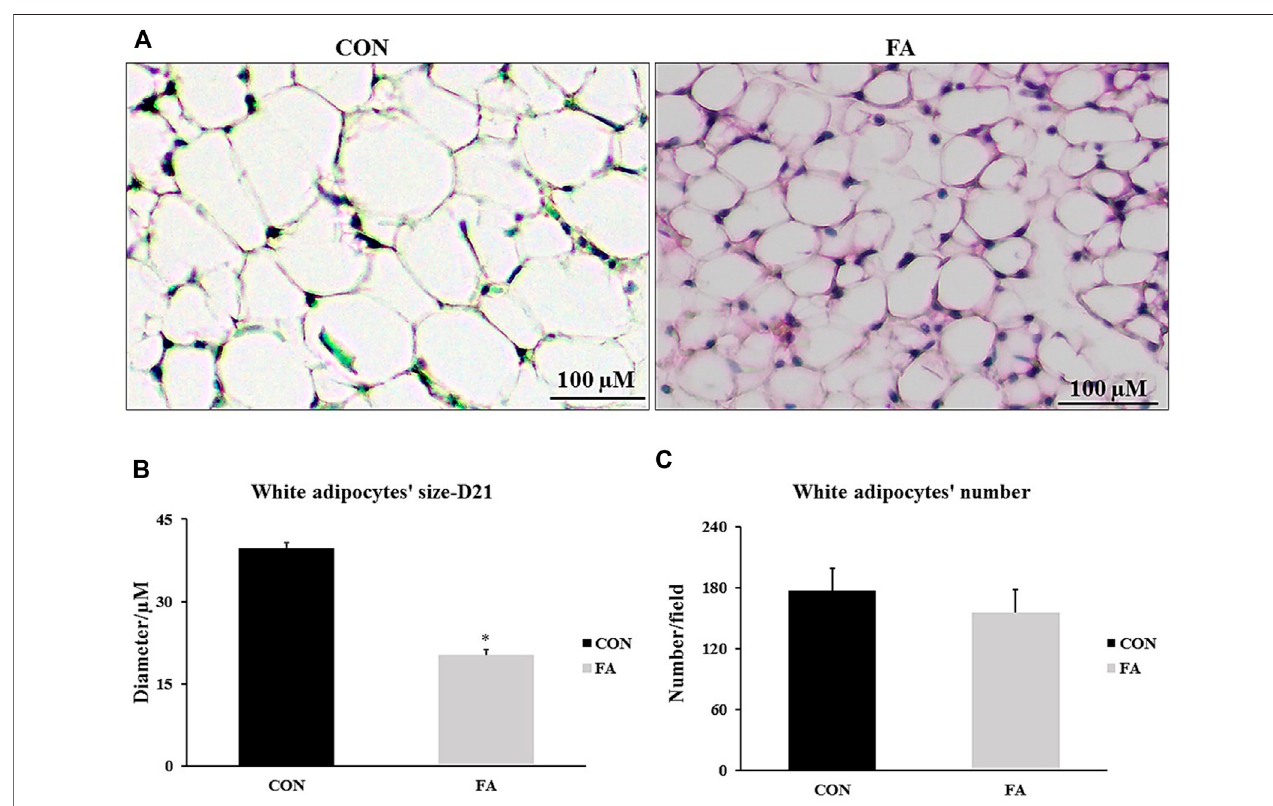
FIGURE13| Effect ofmaternalintakeofEPA/DHAonperi-renal fatpadsof21-day-oldmice.Themotherswerefedeithercontroldiet(CON)orEPA/DHA enriched diet(FA)duringtheentireperiodofpregnancyandlactation. (A) ArepresentativemicroscopicimageofH&Estainsectionsfromeachgroup.Themagni fi cationis×10and scale bar is 100 μ m. (B) The Difference in adipocytes size measured in micrometer. (C) The differences in adipocyte number between different groups. Data represents as mean ± SEM. p < 0.05 by Student ’ s t-test ( n = 8 pups).